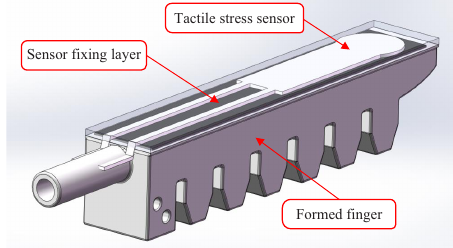
Figure 5. Tactile physiotherapy finger.